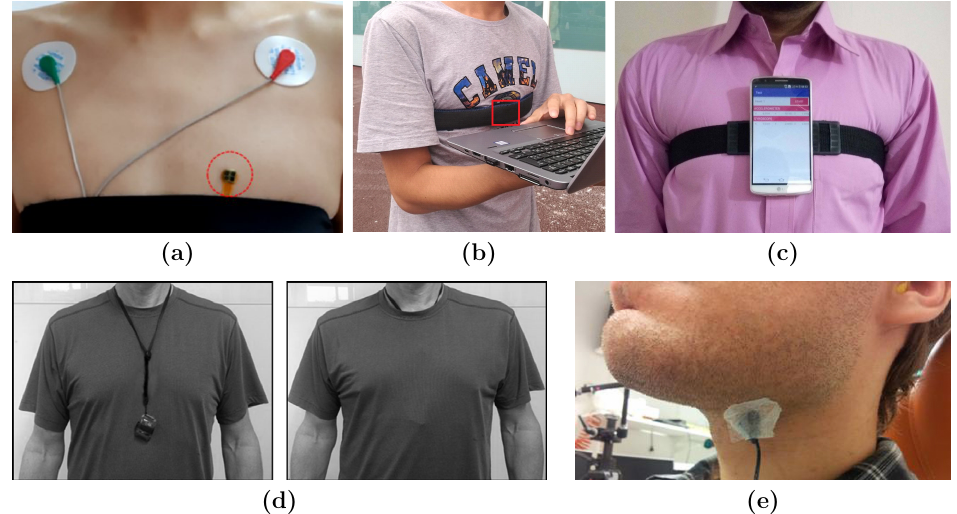
Figure 4. Examples of IMU attachments on the body taken from the referenced studies. ( a ): IMU attached to skin for SCG [54]. ( b ): Use of stretching strap to attach the IMU over clothes for localiza- tion [68]. ( c ): Elastic strap used to attach smartphone over clothes for ER [51]. ( d ): Use of a soft nylon necklace over and underneath clothes for EE estimation [34]. ( e ): Attachment of IMU over the skin using adhesive tape for voice analysis